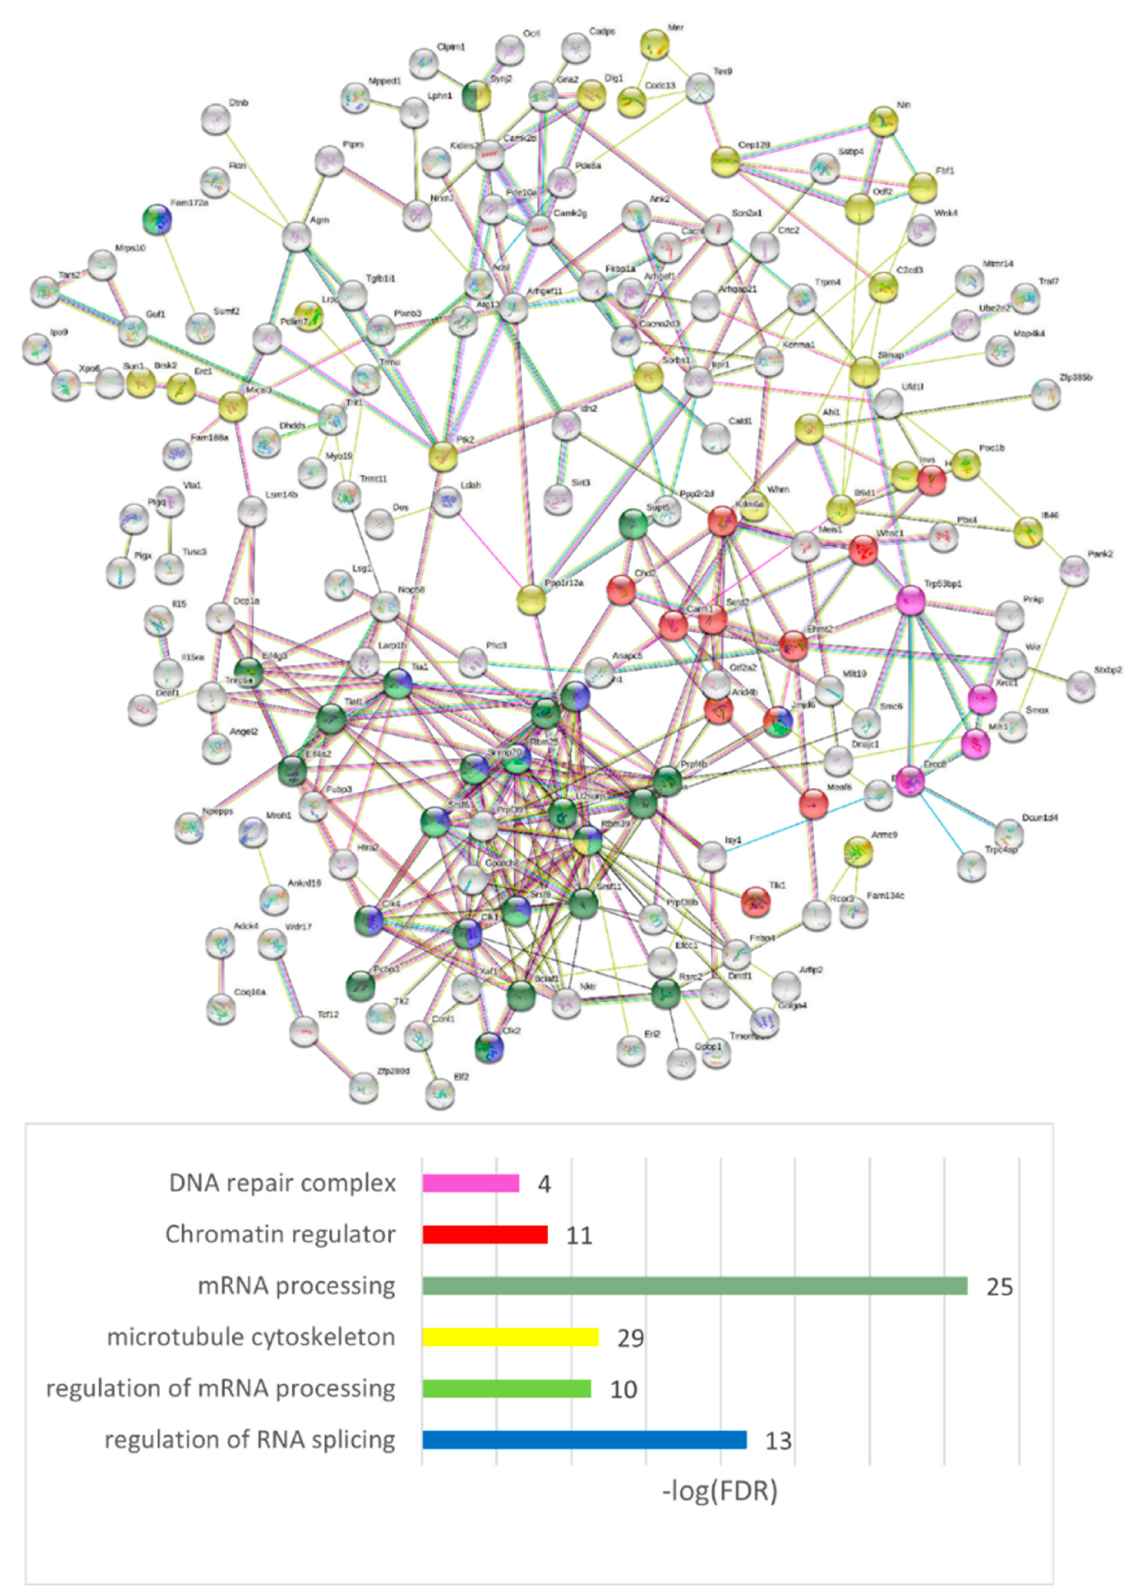
Figure 19. NMD-type ES event abundant genes (Table S7b) were mostly assigned to the nuclear compartment. Full GO annotation is shown in Table S7c. See Table S7b for an expanded network version of the figure.